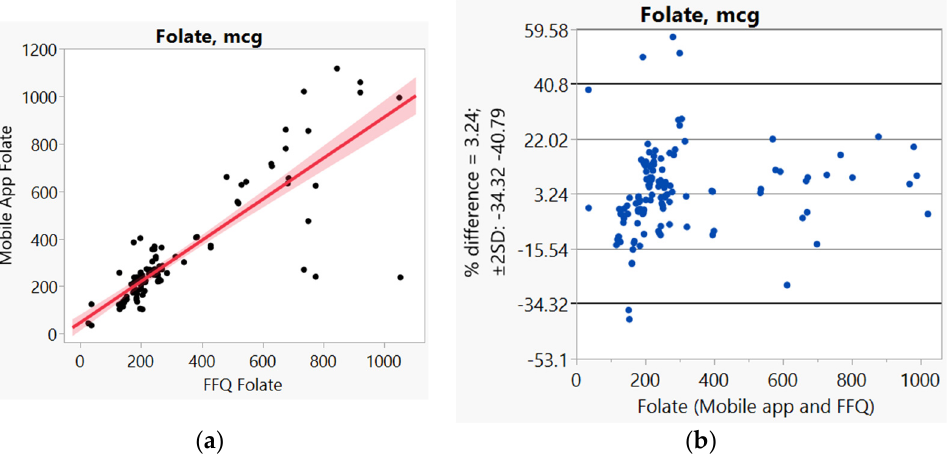
Figure 3. ( a ) Correlation, ( b ) Bland and Altman plots between mobile application and Food Frequency Questionnaire (FFQ) for folate.